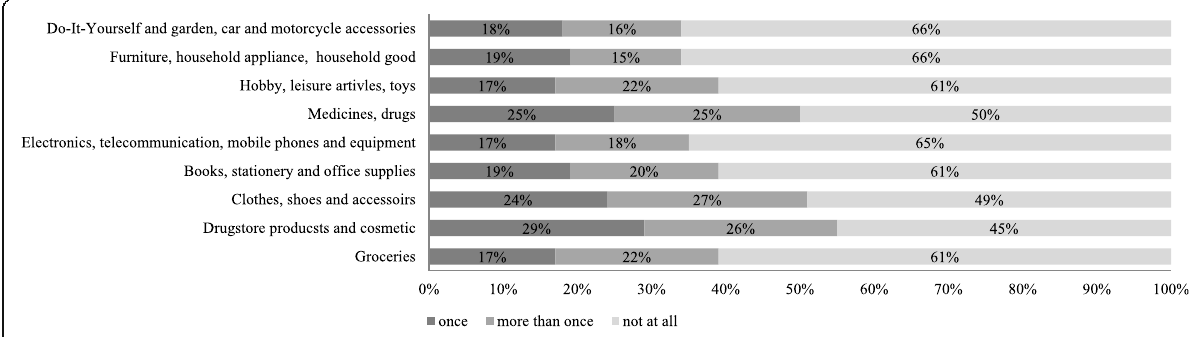
Fig. 3 Frequency of purchase of various product types online instead in a store since the Coronavirus outbreak (only people who purchased products online because of the Coronavirus pandemic, n = 232)